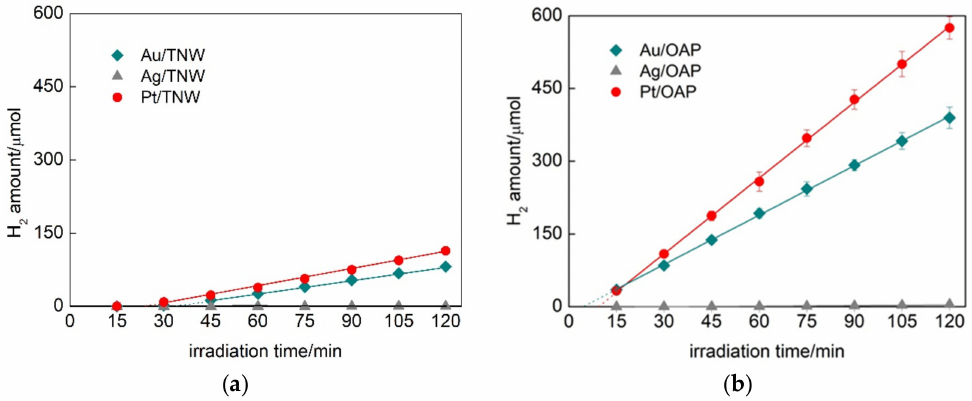
Figure 3. Hydrogen evolution during metal photodeposition on: ( a ) TNW and ( b )